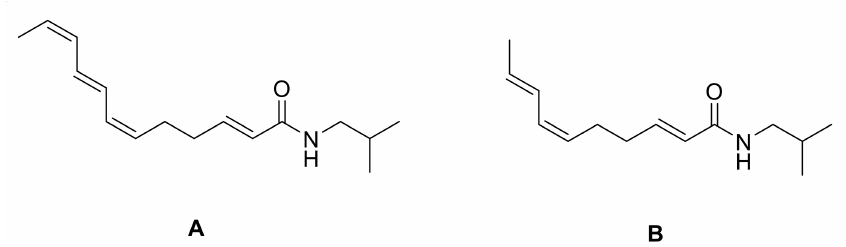
Figure 4. Neoherculin ( A ) and spilanthol ( B )